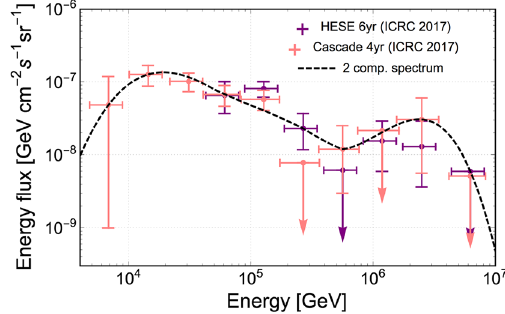
Fig. 5 Example of non trivial astrophysical neutrino energy spectrum characterized by two peaks. In the same figure 6 years of HESE and 4 years of cascades are reported according to